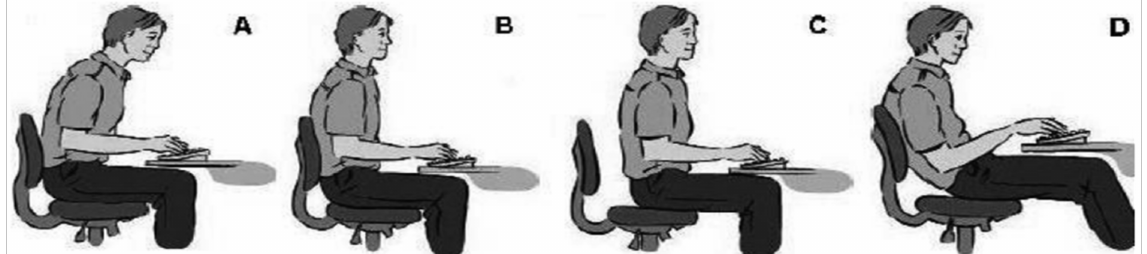
Figure 1. Possible positions in which participants may sit, including variables (altering position at least once per half hour). ( A ). Leaning forward, ( B ). Upright sitting with backrest, ( C ). Upright sitting without backrest, ( D ). Slouching backward. Reprinted with permission from [12].